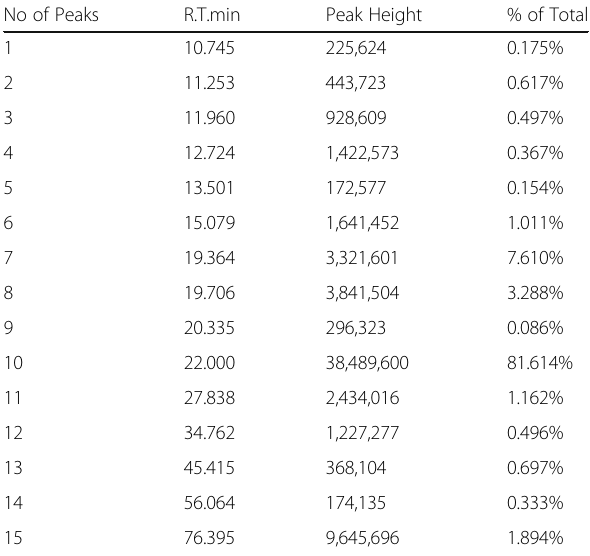
Table 3 Analysis of GC-MS chromatogram of chloroform extract of Rhazya stricta stems (RS1S CHCL 3 ) No of Peaks R.T.min Peak Height % of